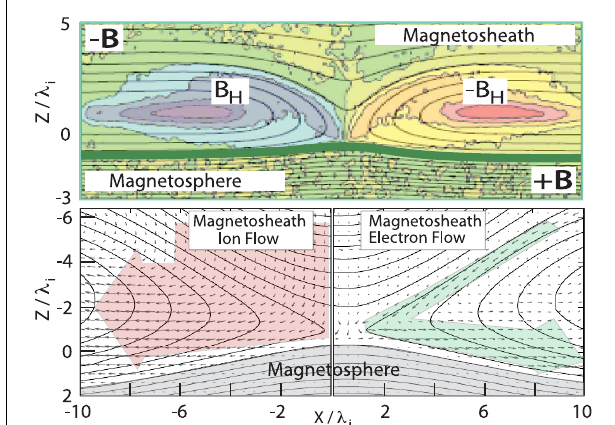
FIGURE 8 | Non-forced non-guide field particle-in-cell simulations of asymmetric magnetopause reconnection with (Top) Hall field B H in color coding overlaid on background field (simulation data after Pritchett [148] courtesy American Geophysical Union). The fat green line is the magnetopause which separates the magnetosheath from the undistorted magnetosphere. The magnetopause remains intact except for having been pushed down from its original position at z = 0 to roughly − z = − 1 (in units of λ i ) and slightly distorted. The magnetopause coincides approximately with the inner separatrix. Only two large Hall field vortices develop on the magnetosheath side. Bottom panels: Ion (left) and electron (right) bulk flows on the magnetosheath side develop (only half spaces are shown). Jetting of electrons is restricted to a narrow domain only along the